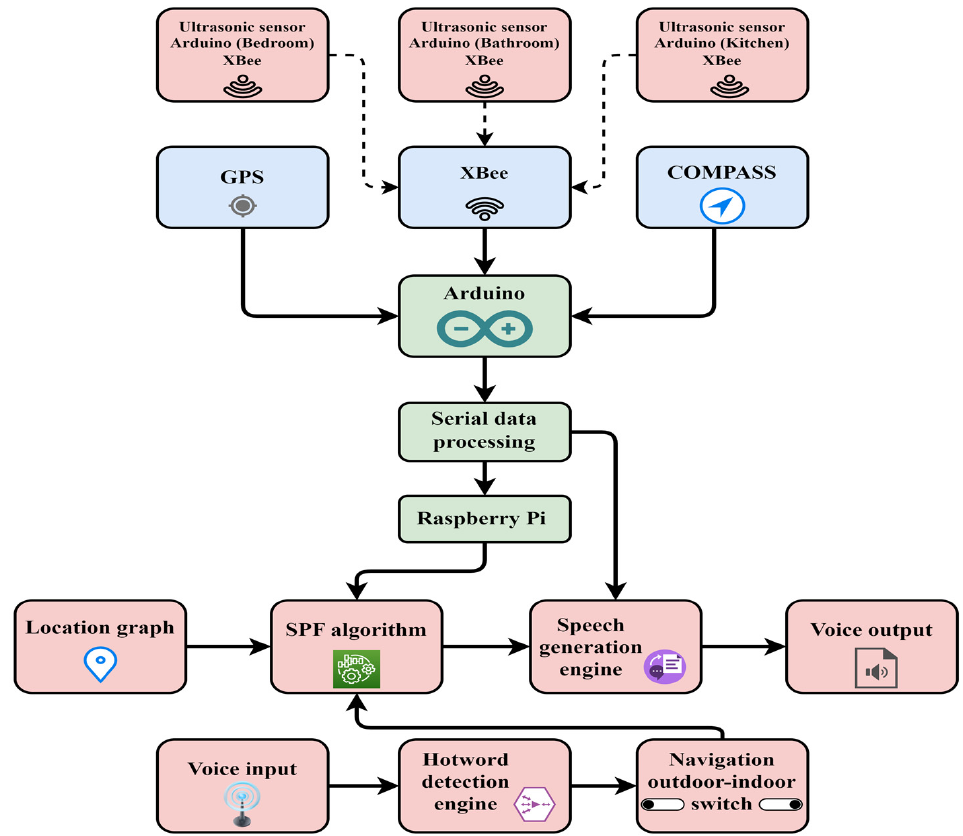
Figure 1. Illustrates the block diagram of proposed method.